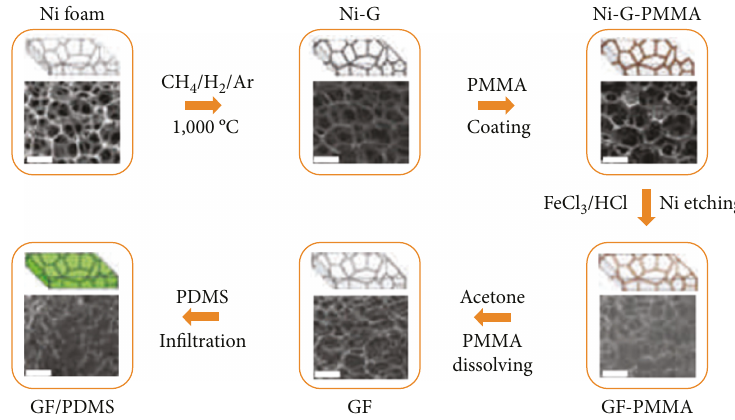
Figure 5: Synthesis of a GF and integration with PDMS. (a) A nickel (Ni) foam. (b) CVD growth of graphene fi lms (Ni – G) using Ni foam as a 3D sca ff old template. (c) An as-grown graphene fi lm after coating a thin PMMA supporting layer (Ni – G-PMMA). (d) A GF coated with PMMA (GF-PMMA) after etching the nickel foam with hot HCl (or FeCl /HCl) solution. (e) A free-standing GF after dissolving the 3 PMMA layer with acetone. (f) A GF/PDMS composite after in fi ltration of PDMS into a GF. All the scale bars are 500 μ m